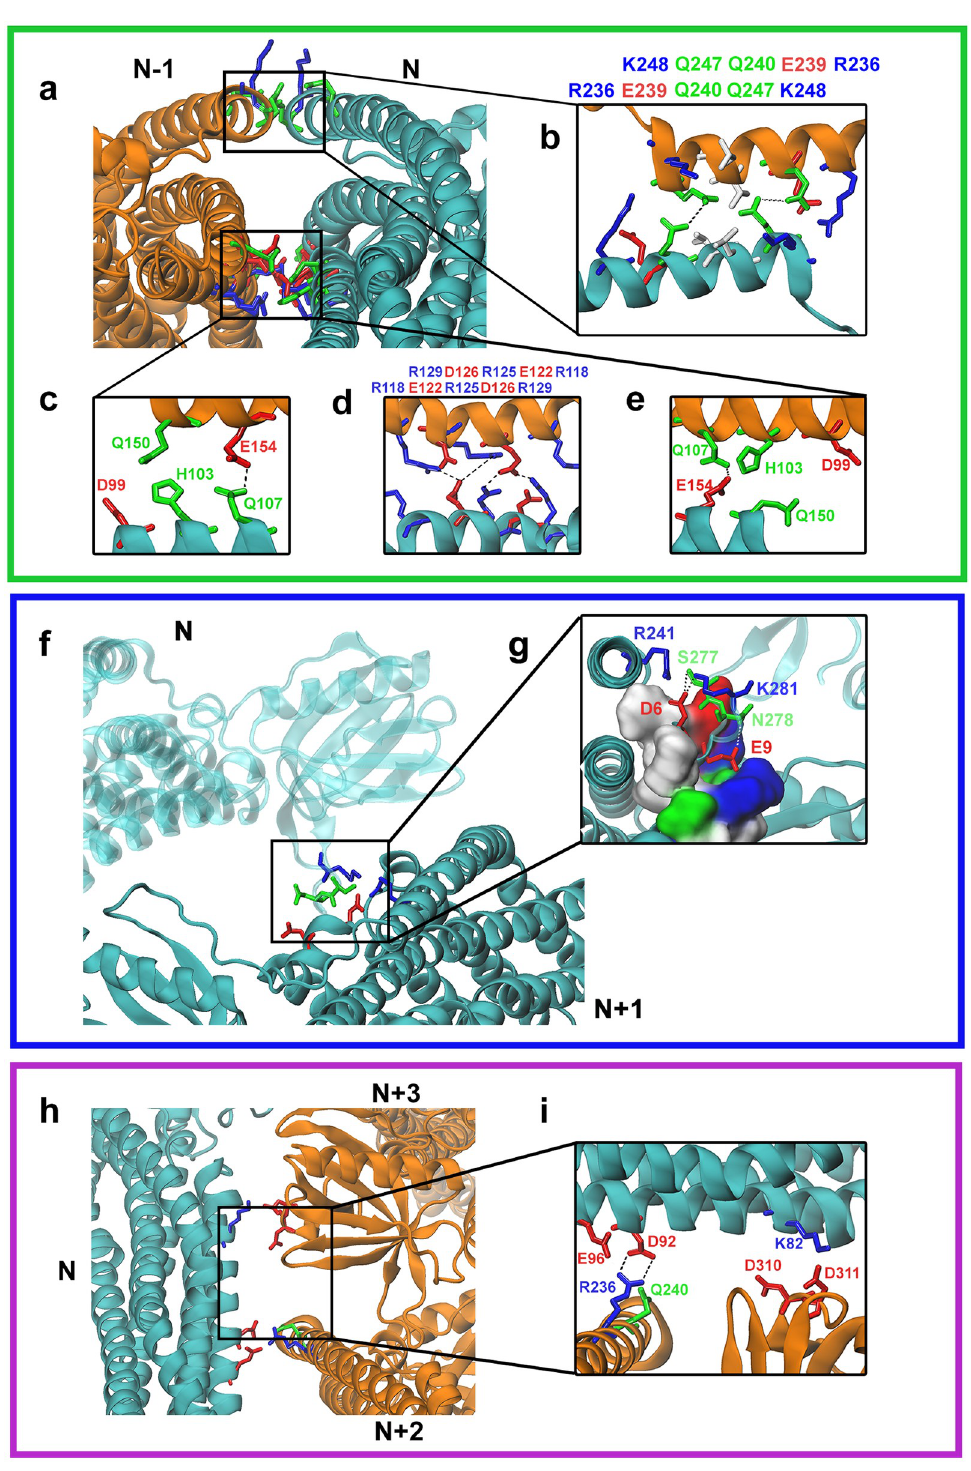
Fig 2. Identification of key interacting residue pairs between protein dimers inside the ACAP1 BAR-PH protein lattice. ( a , f , h ) Enlarged views of the interacting regions. Residues are coloured according to residue types, i.e., negative: red; Positive: blue; Polar: green; Non-polar: white. ( b ) A symmetrically anti-parallel interacting residue pairs at Interface I. ( c- e ) Another symmetrically anti-parallel interacting residue pairs at Interface I. ( g ) A binding pocket from dimer N+1, shown in surface representation, forms Interface II by interacting with residues from dimer N. ( i ) Interacting residues at Interface III. In close-up panels, dotted lines indicate salt bridges or hydrogen bonds between charged residues.